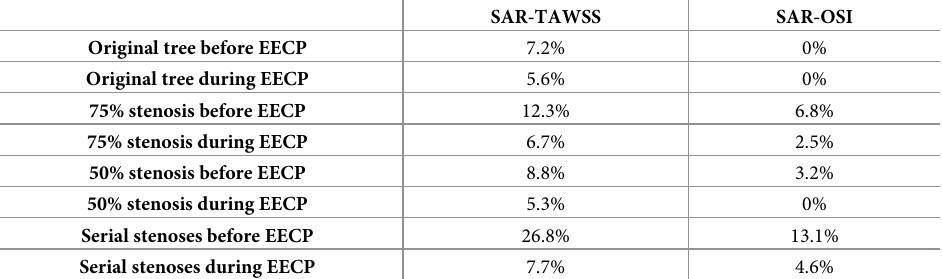
Table 1. SAR-TAWSS and SAR-OSI at the mother vessel in the first bifurcation of LAD arterial tree.